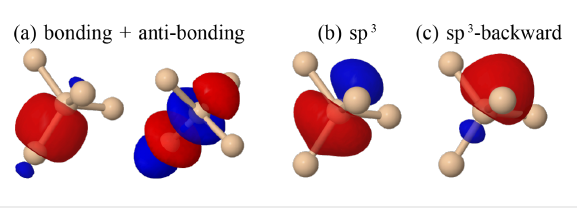
Figure 8: Using the Marzari–Vanderbilt algorithm, three different sets of Wannier functions (WFs) with comparable spread can be obtained for bulk silicon. While (a) bonding + antibonding and (b) sp 3 -forwards are the most “physical” WFs, though not the most localized ones, and (c) sp 3 -backward are the maximally localized